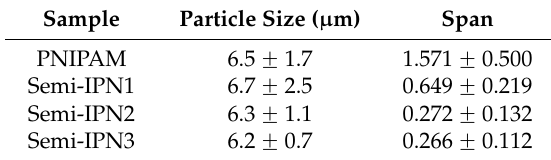
Figure 7. TEM images of semi-IPN with different initiator amounts (samples were labeled with uranyl acetate).